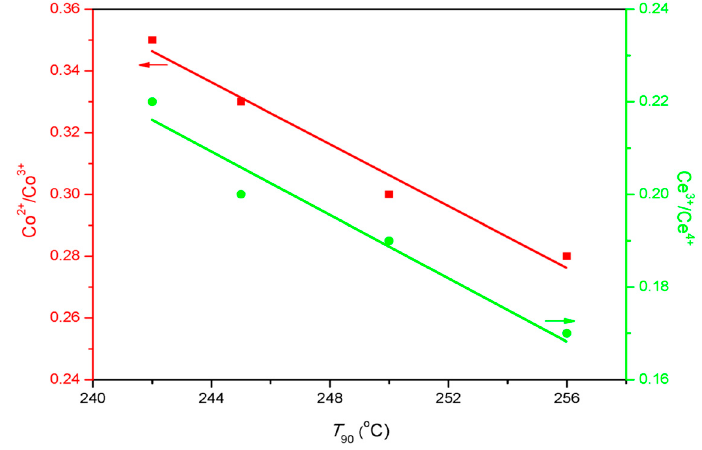
Figure 9. The relationship between surface O ads /O lat ratio and catalytic activities ( T 50 , T 90 ).